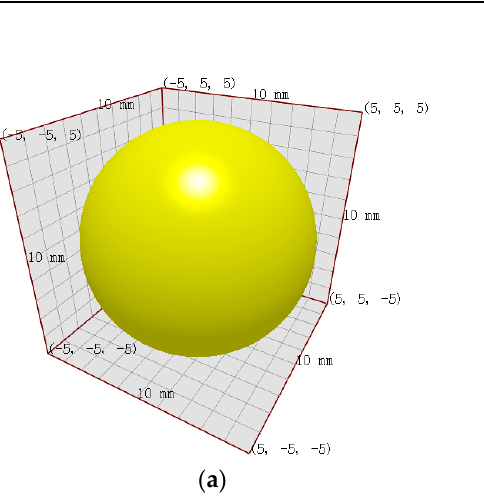
Figure 4. Soil particle model. ( a ) Single spherical particles. ( b ) Lumpy particles. To build a relevant stalk discrete element model [24–27], a green manure stalk model on the soil surface was constructed. Based on the green manure returning test of the orchard area in summer, the size of the broken green manure stalks was found to be mainly distributed between 50 mm and 100 mm. In this study, 17 particles with a diameter of 6 mm and 27 particles with a diameter of 6 mm formed the approximate cylinder-shaped green manure stalk simulation models consisting of 60 mm and 90 mm in length, respectively (Figure 5). These two models represented the green manure stalks after breaking and pavement.